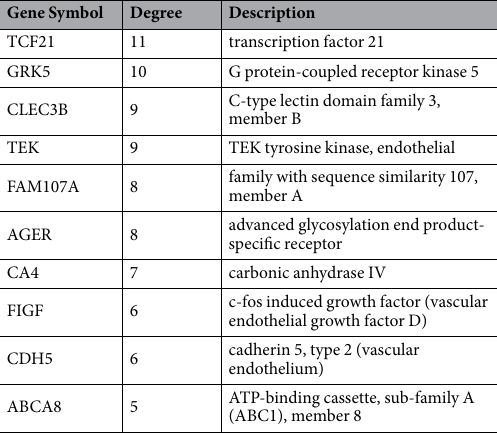
Table 2. Top 10 hub genes in the gene co-expression network of the DEGs that eliminated gender differences for